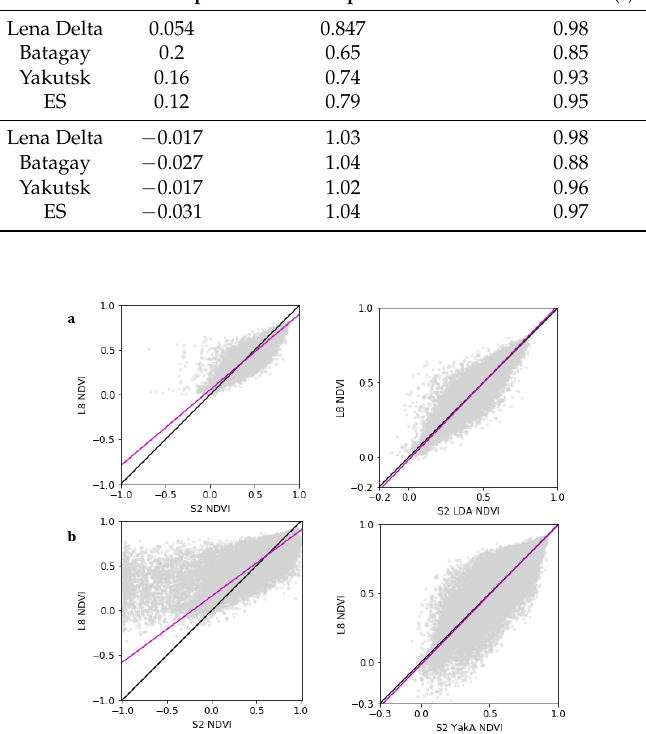
Figure 5. Comparison of NDVI values from the Lena Delta (( a ), upper row) and Yakutsk (( b ), lower row). Left plots: NDVI calculated from observed Landsat-8 and Sentinel-2 surface reflectance values. Right plots: NDVI calculated from adjusted Sentinel-2 and observed Landsat-8 reflectance values. The solid black line is one-to-one, and the pink line is the ordinary least squares regression trend